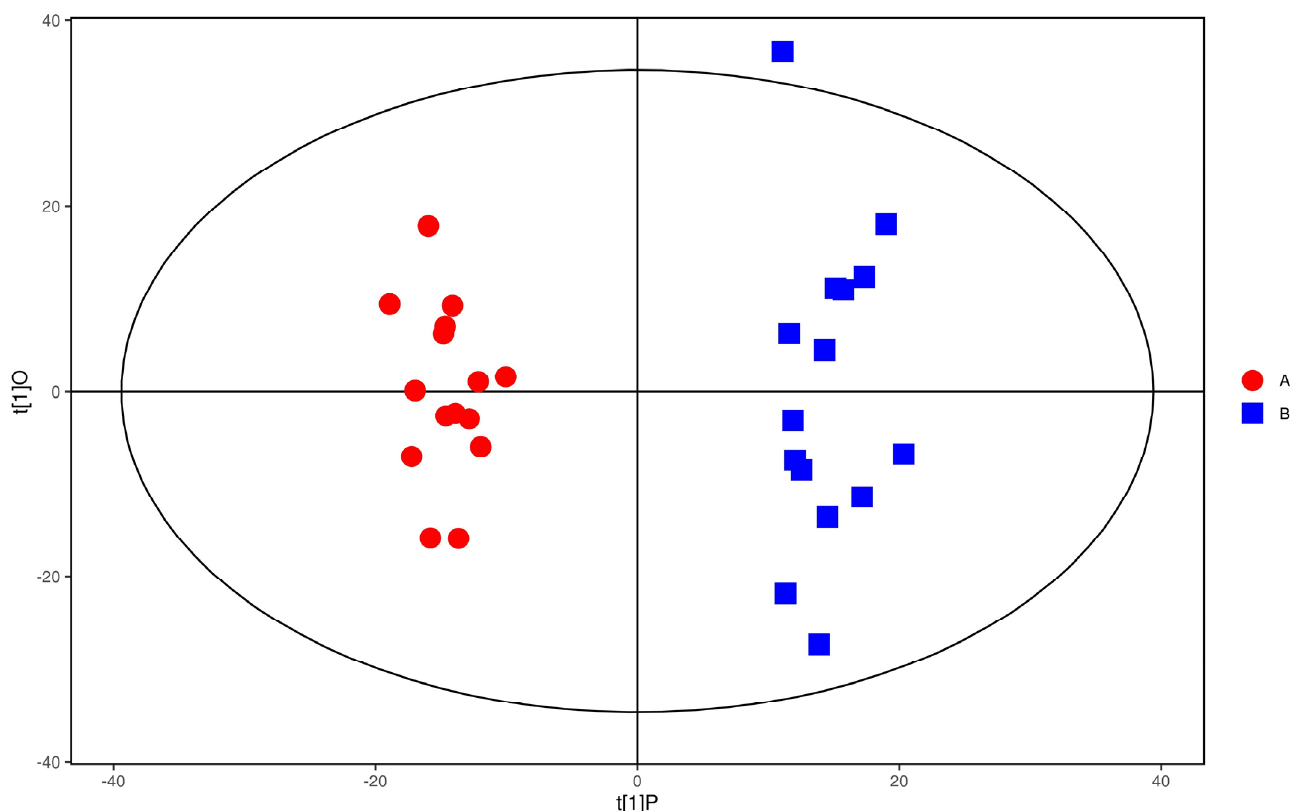
Figure 5. PCA score of positive ions. Red dots represent the control group, and blue dots represent the study